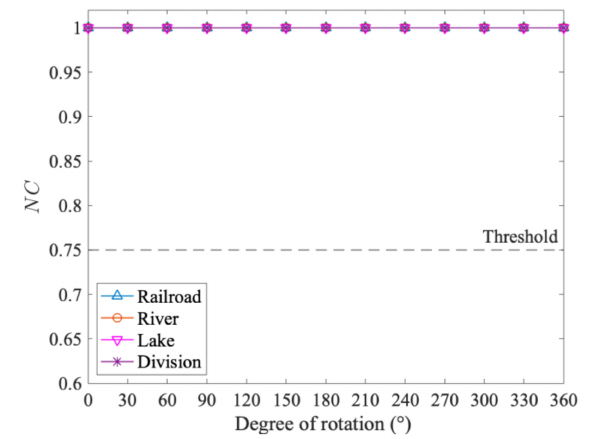
Figure 11. The results of rotation